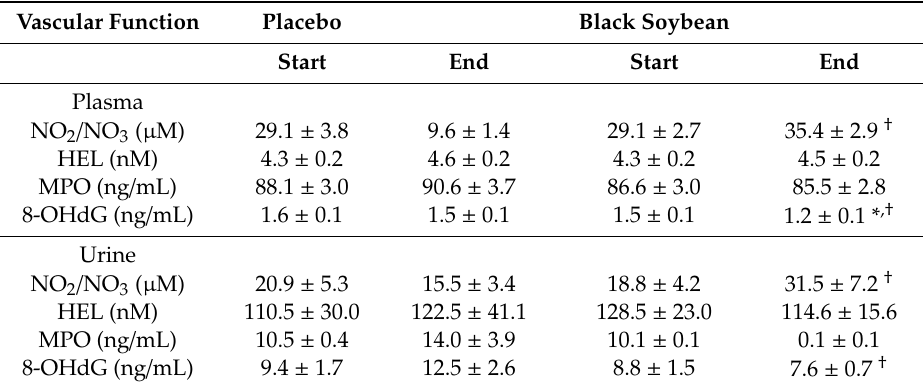
Table 5. The e ff ects of black soybean consumption on the antioxidant activity. Vascular Function